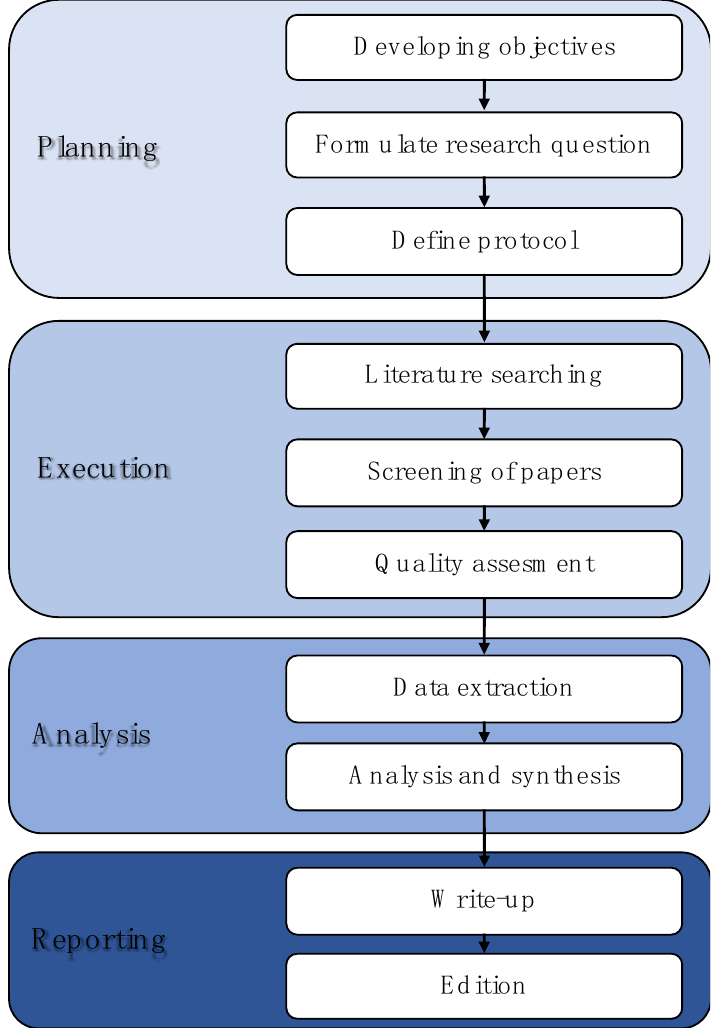
Figure 2. Scheme of SLR stages followed in this research.